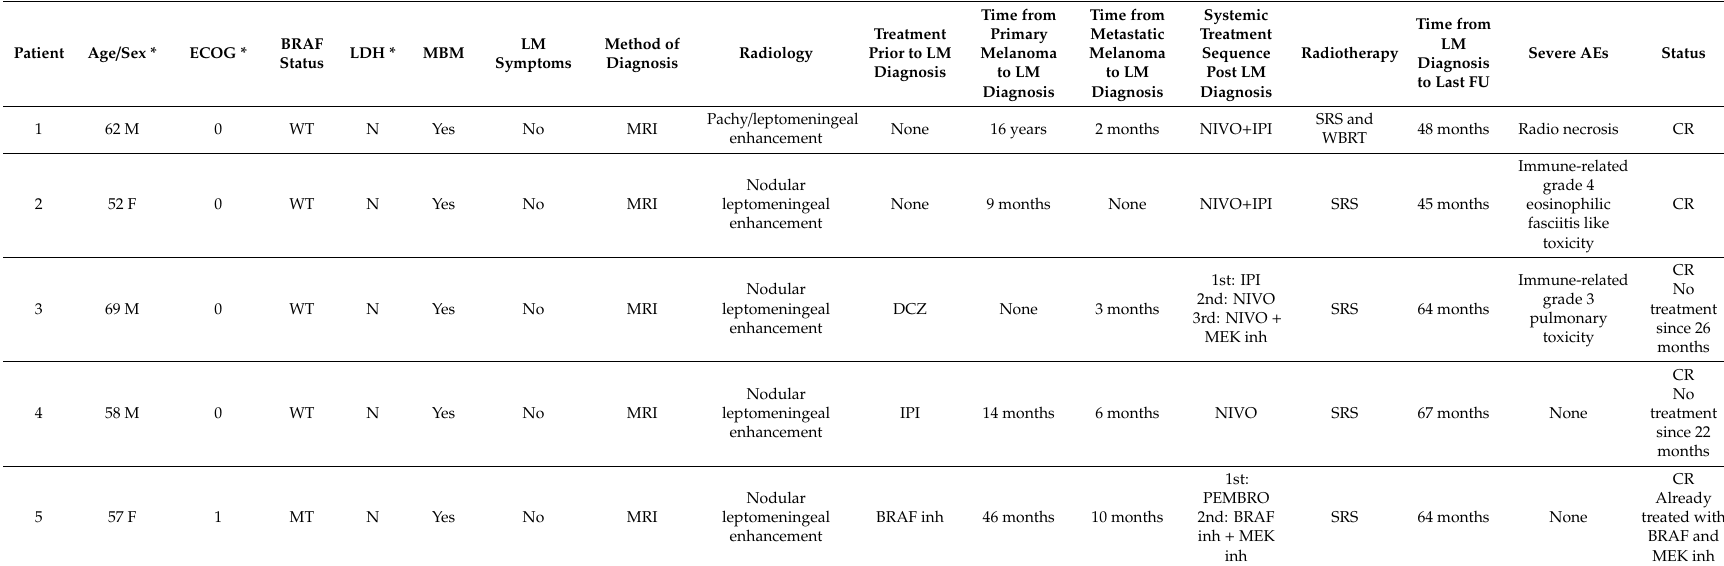
Table 3. Characteristics of alive patients at the time of data